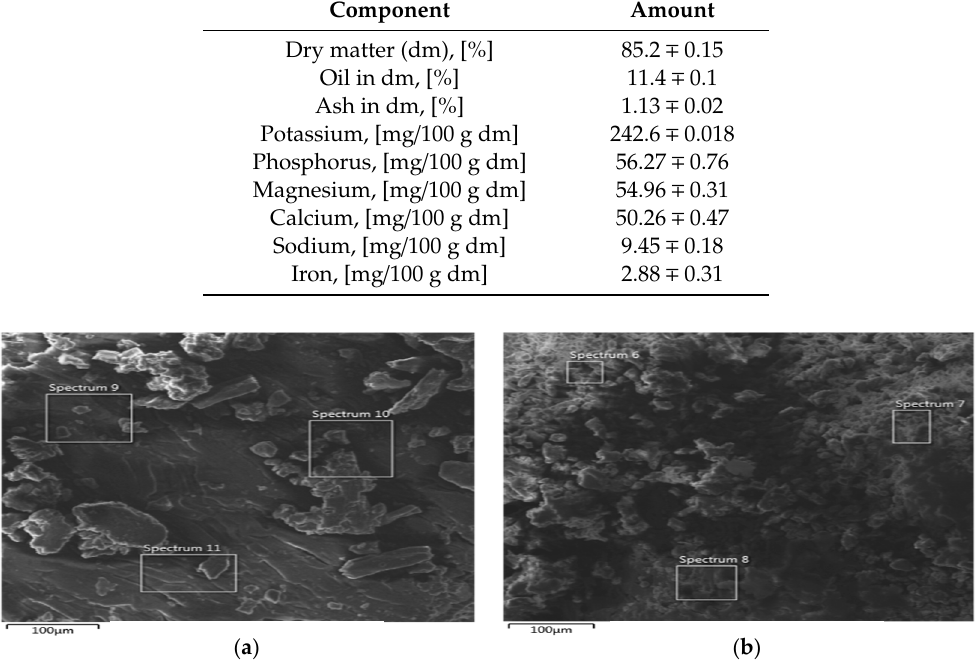
Figure 4. SEM images of ground date seeds ( a ) before and ( b ) after oil extraction.